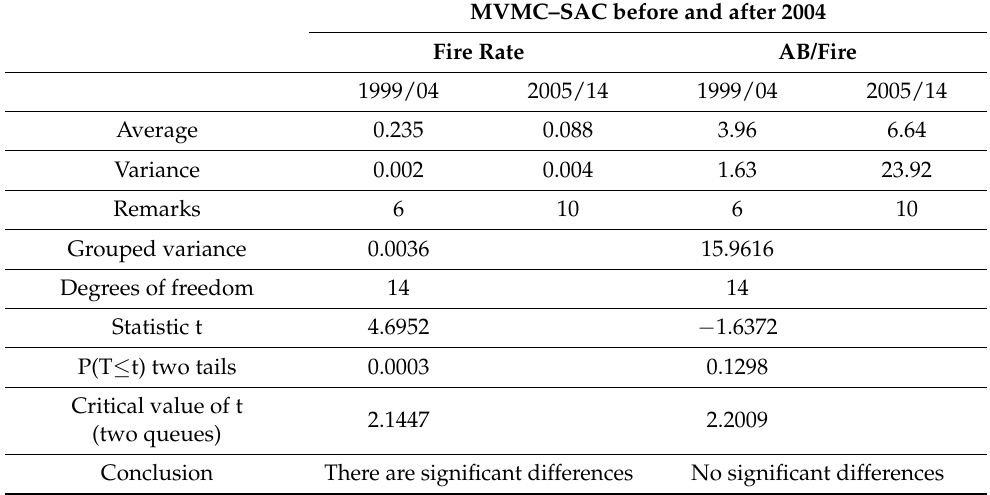
Table 5. Significant differences in the rate of forest fires and in the area burned by fire (BA/wildfire) in MVMC with SAC, before and after